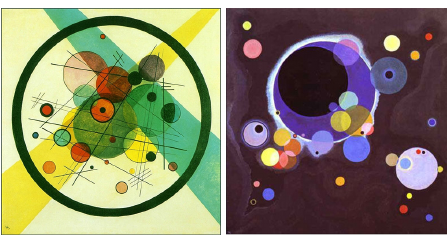
Figure 1. Works by Kandinsky, which can be downloaded from an open-source website http://image.